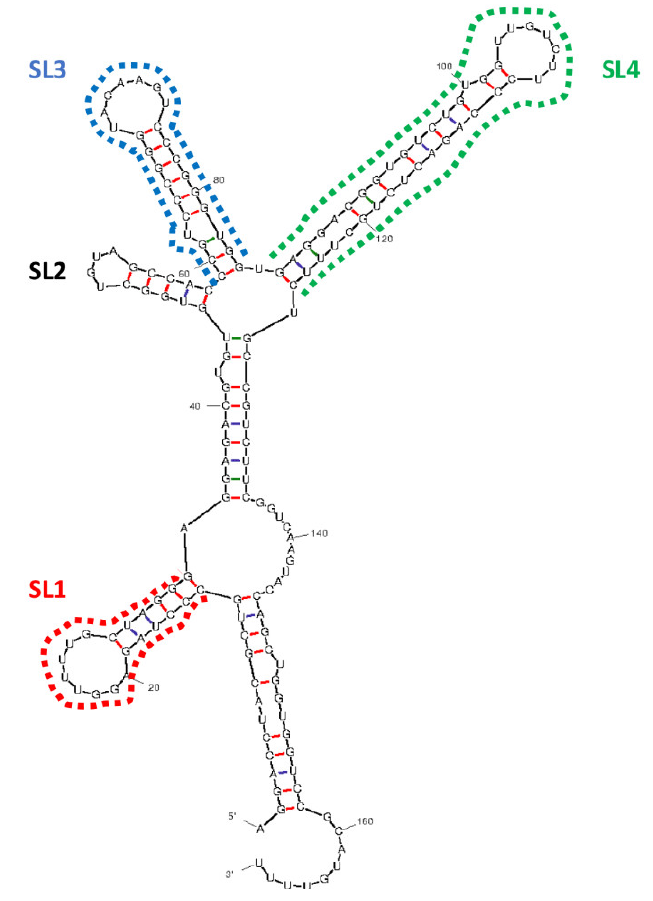
Figure 1. Secondary structure of wildtype EBER1 . Secondary structure of EBER1 was determined using the mfold web server. Stem-loops that were deleted to create ∆ SL1, ∆ SL3, and ∆ SL4 deletion mutants are indicated (dotted lines).